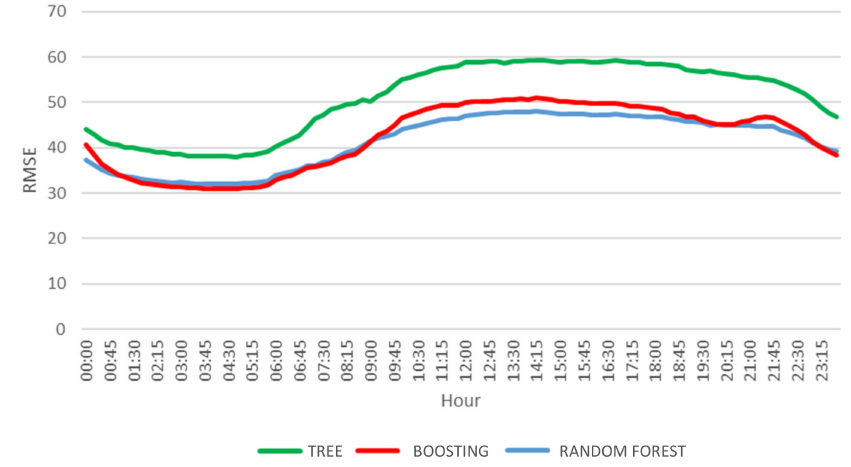
Figure 12. Monthly relative RMSE for each quarter of an hour of the